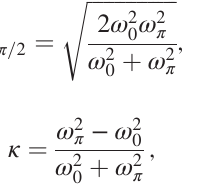
FIG. 2. The shunt impedance per unit length R 0 and the normalized modified Poynting vector S the cell rounding radius r 0 for iris radius a ¼ 3 . 2 mm.